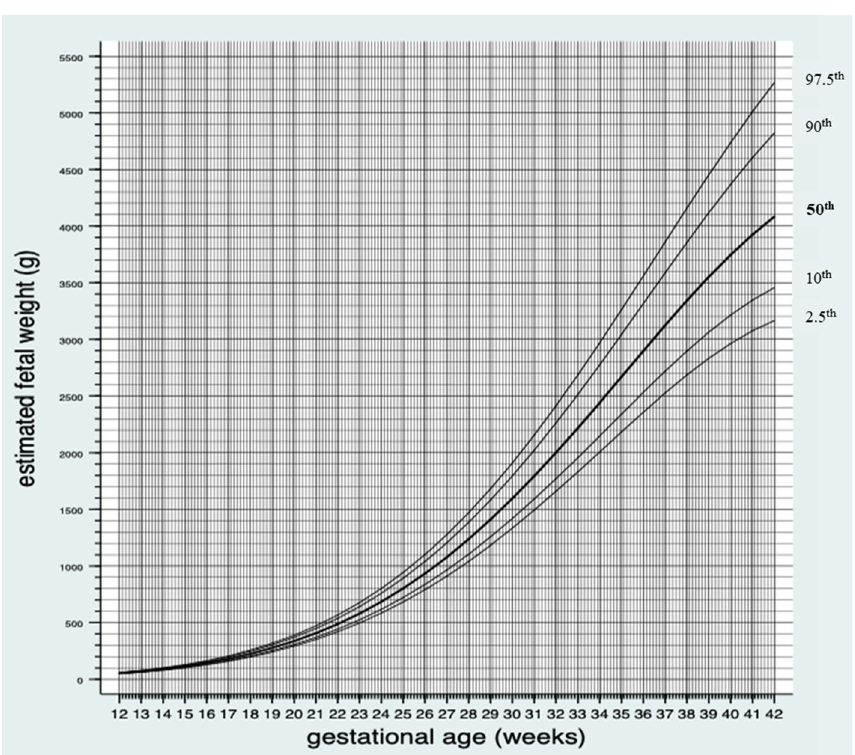
Figure 3. Median and variance in percentiles (2.5th, 10th, 50th, 90th and 97.5th) of estimated fetal weight by gestational age for male and female